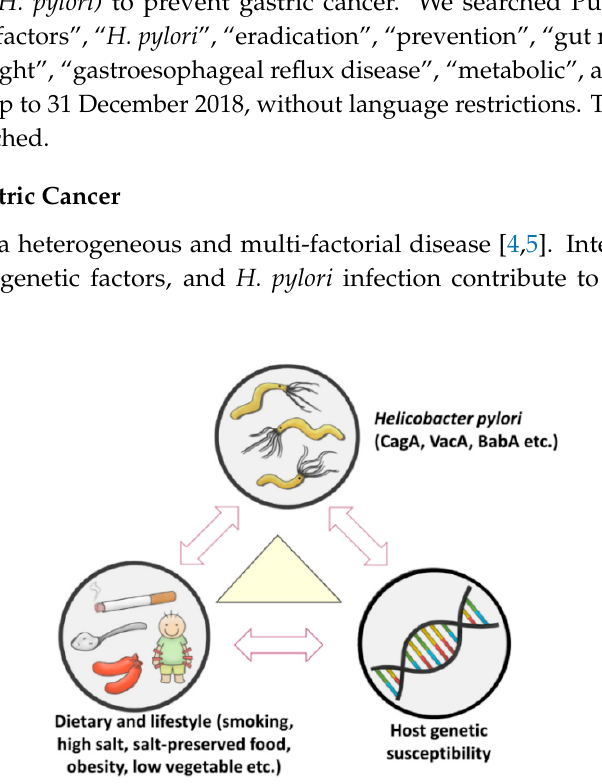
Figure 1. Risk factors of gastric cancer. Interaction of dietary and lifestyle factors, host genetic factors, and H. pylori infection contribute to gastric